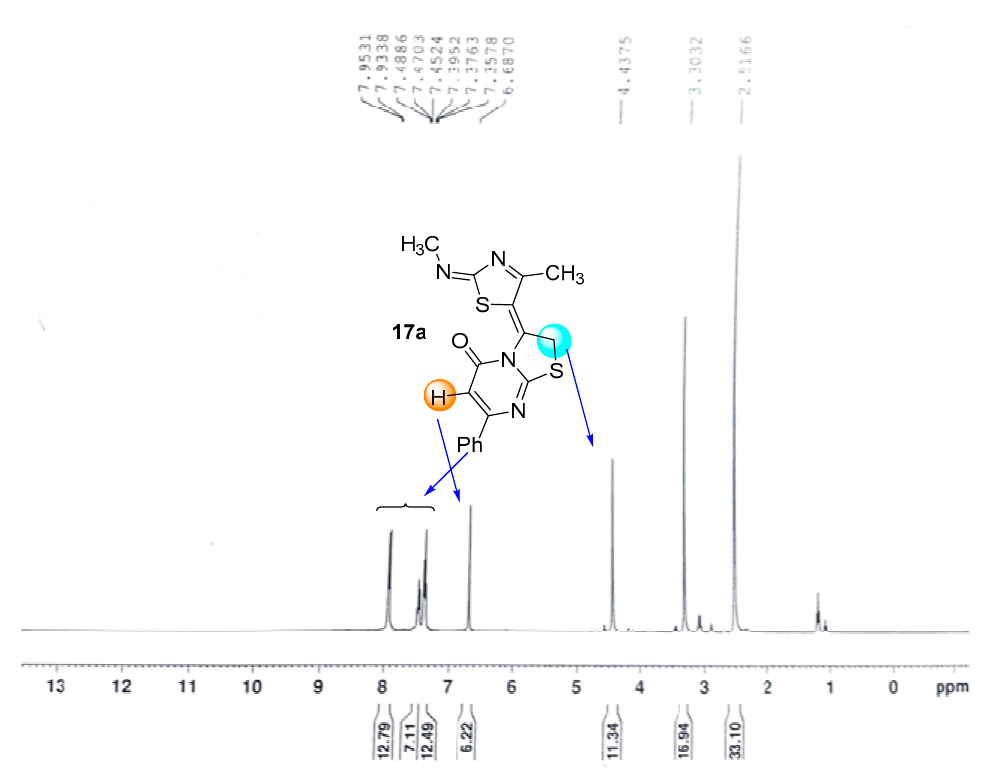
Figure 2. 1 H-NMR spectrum of compound 17a which exists in the tautomeric form C.